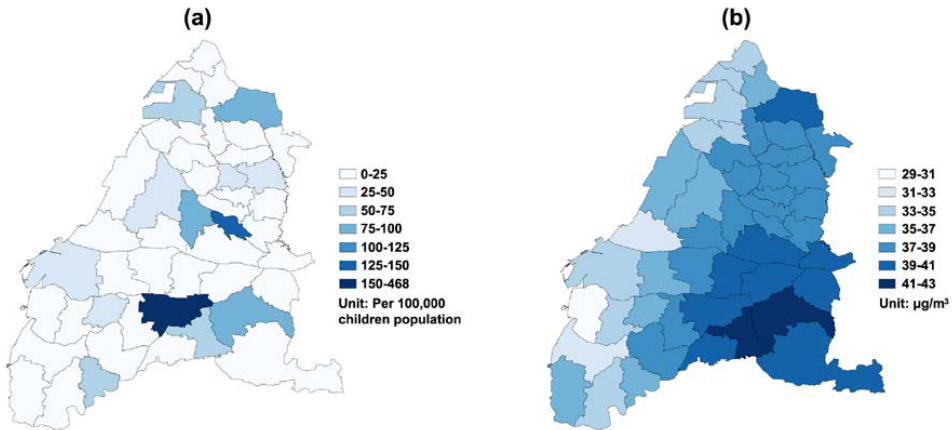
Figure 3. Geographical distribution of the ( a ) crude asthma visit rates (/100,000 children) and ( b ) daily average PM 2.5 concentration (μg/m 3 ) at the district level in Changhua County and Yunlin County from 2005 to 2010.